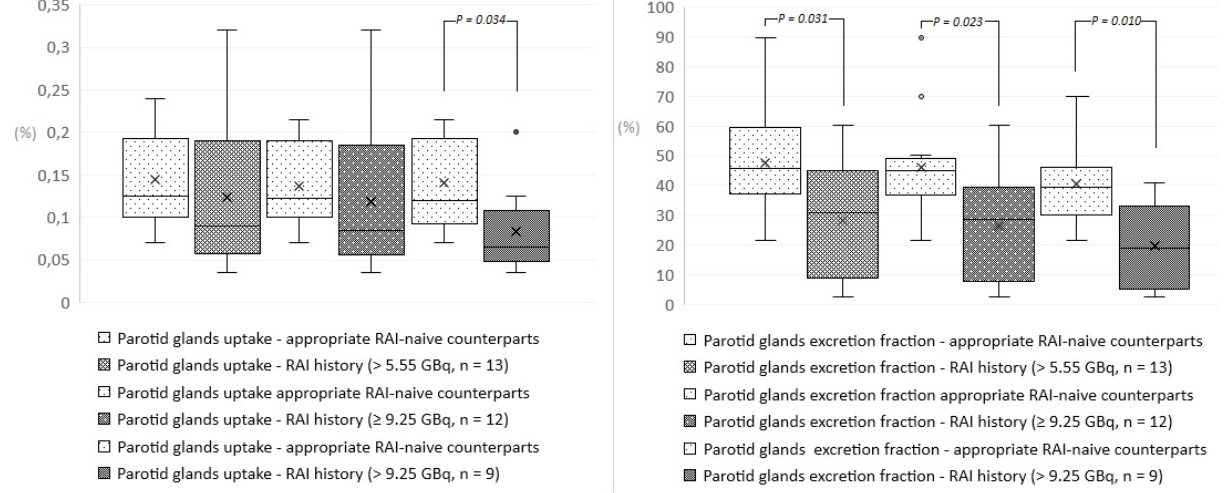
Fig. 2. Parotid glands uptake (left) and excretion fraction (right) in patients treated with RAI activities >5.55GBq, ≥9.25 GBq and >9.25 GBq. P values from Mann-Whitney